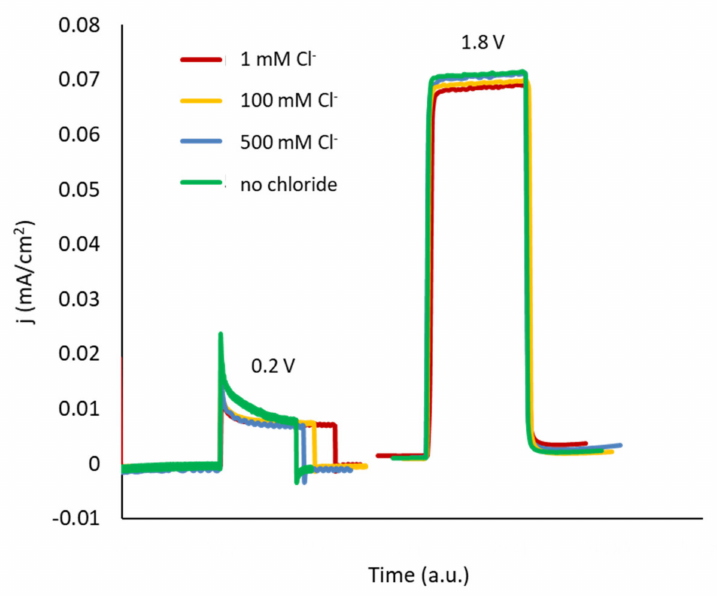
Figure 7. Potentiostatic tests performed with solution containing 0.1 M NaClO 4 and different concentration of chloride ions at 0.2 and 1.8